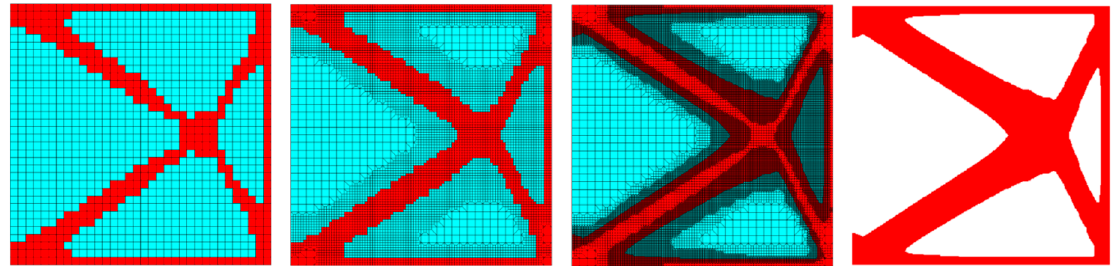
Figure 36. Selected middle topologies and the final one for the structure under two-load case—for the last iteration the grid has not been shown, to improve the clarity of the picture.